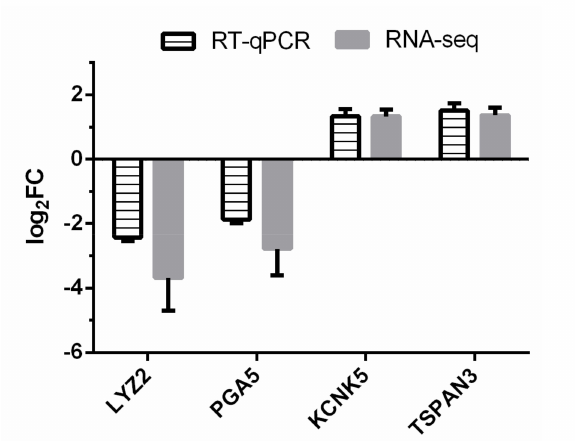
Figure 1. RT-qPCR confirmation of four differentially expressed genes (DEGs) identified by RNA-seq. Log 2 FC (high efficiency (HE) vs. sterilized rumen content (Con)) of target genes were calculated for both RNA-seq and RT-qPCR methods.